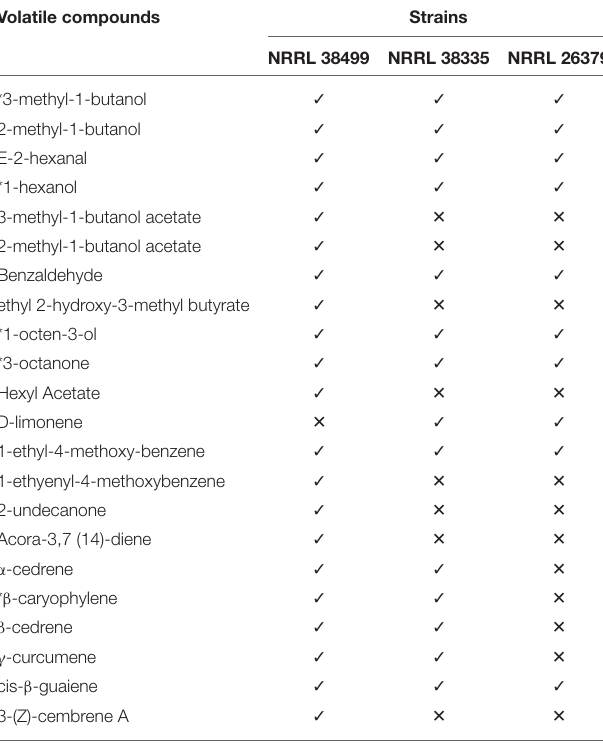
TABLE 2 | Identified F. oxysporum volatile